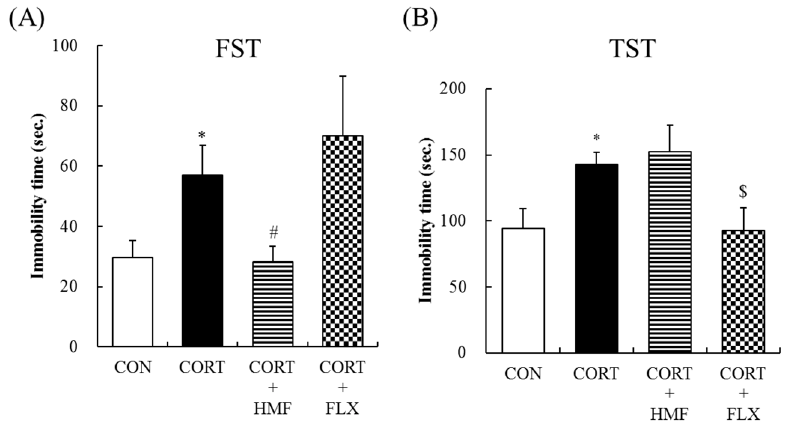
Figure 3. Effects of HMF on corticosterone-induced behavioral abnormalities in the forced swim test ( A ) and tail suspension test ( B ). Values are means ± SEM ( n = 7–8). Symbols show significant differences between the following conditions: CON vs. CORT (* p < 0.05), CORT vs. CORT + HMF ( # p < 0.05), and CORT vs. CORT + FLX ( $ p < 0.05).